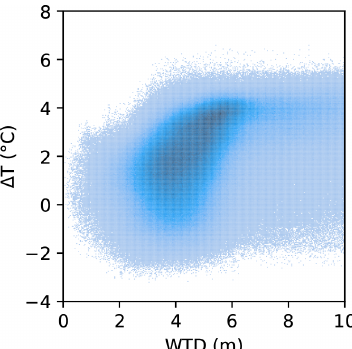
Figure 6e–f show the (cid:49)T 14 : 00 difference between GW